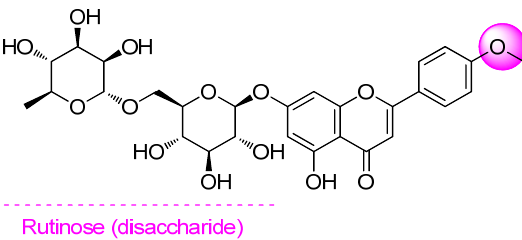
Figure 4. Structure–activity relationship of LN against HIV.